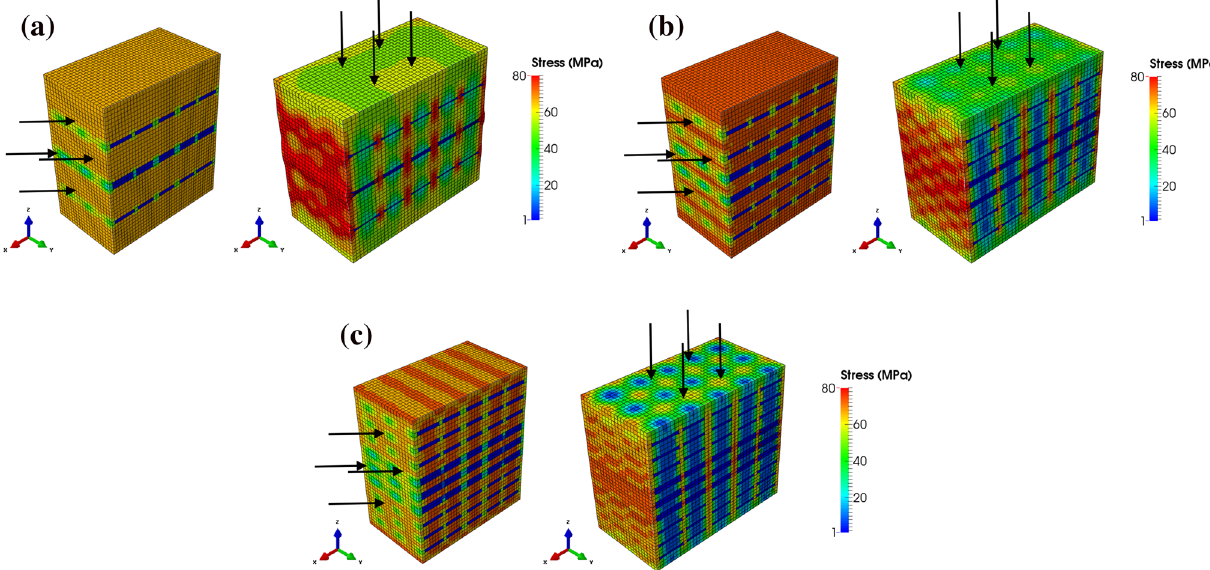
Fig. 7 The view cut of von-Mises stress contour of the specimens with Rubber insulations for the x and z directions: a L3 sample, b L6 sample, c L9 sample (Note: In the figures, left figure is for the x -direction of loading, and right figure is for the z -direction of